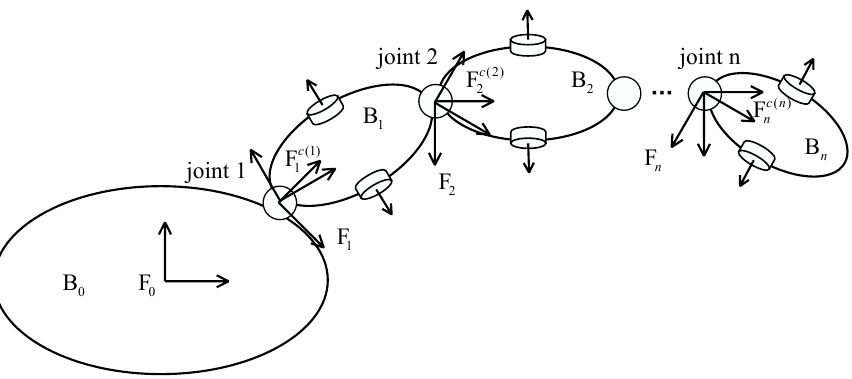
Figure 1. SRS with a satellite platform and a manipulator arm with CMG-actuation.